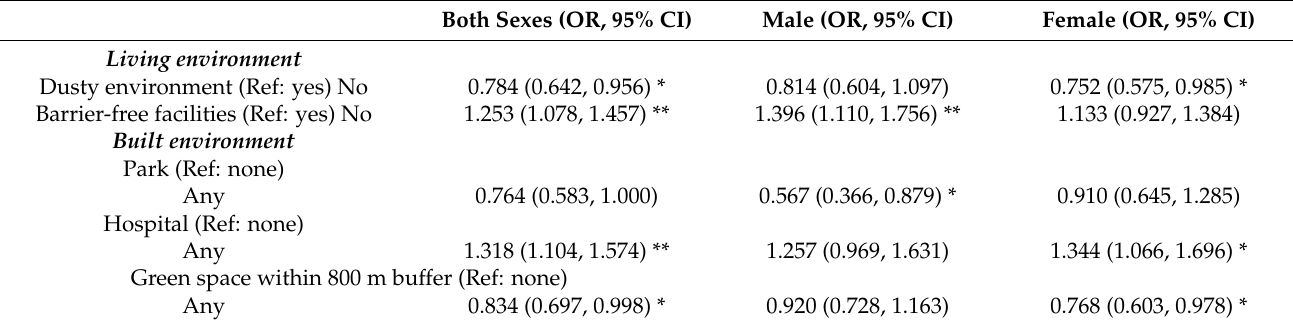
Table 3. Adjusted associations between multiple environmental factors and depression, stratified by sex. Both Sexes (OR, 95% CI) Male (OR, 95% CI) Female (OR, 95% CI) Living